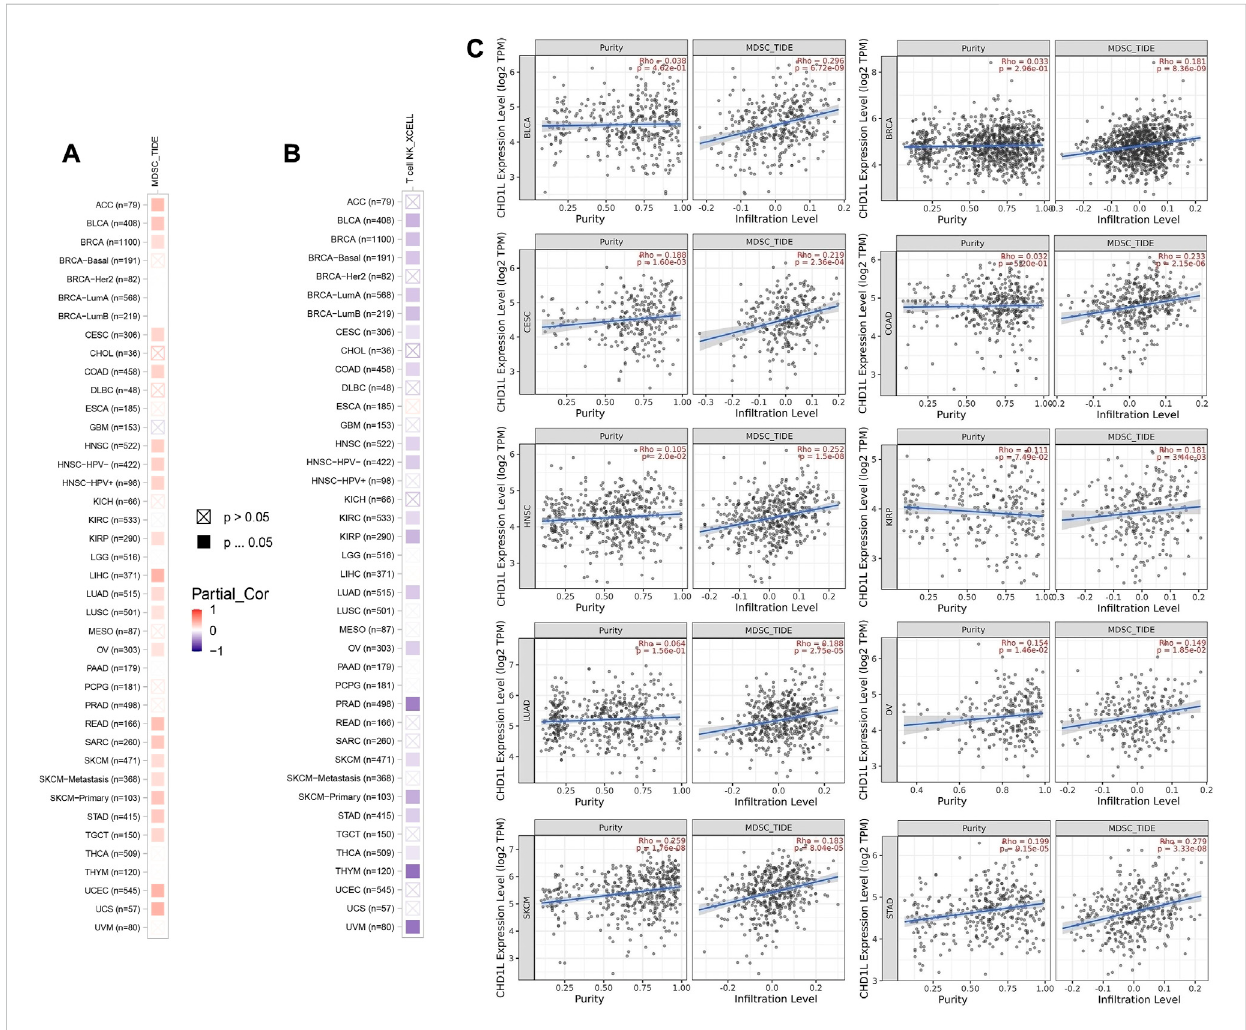
FIGURE 7 The correlation between CHD1L expression level and in fi ltration of (A) myeloid-derived suppressor cells (MDSC) and (B) Natural killer T cells in a panel of human cancers. (C) Scatter plots that demonstrate the correlation between the expression of CHD1L and the in fi ltration level of